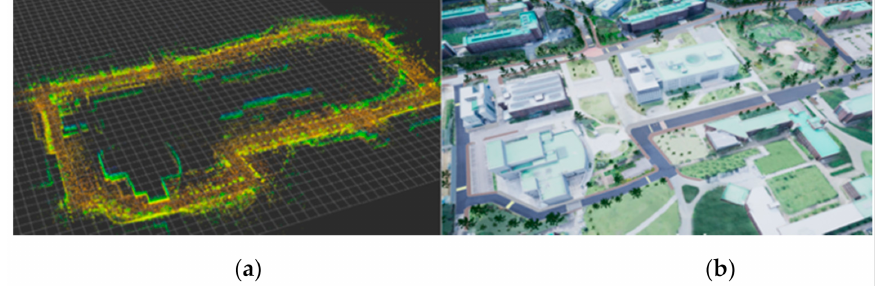
Figure 8. ( a ) Point cloud reference map and ( b ) the environment of the Chungbuk National University, built in the MORAI simulator.